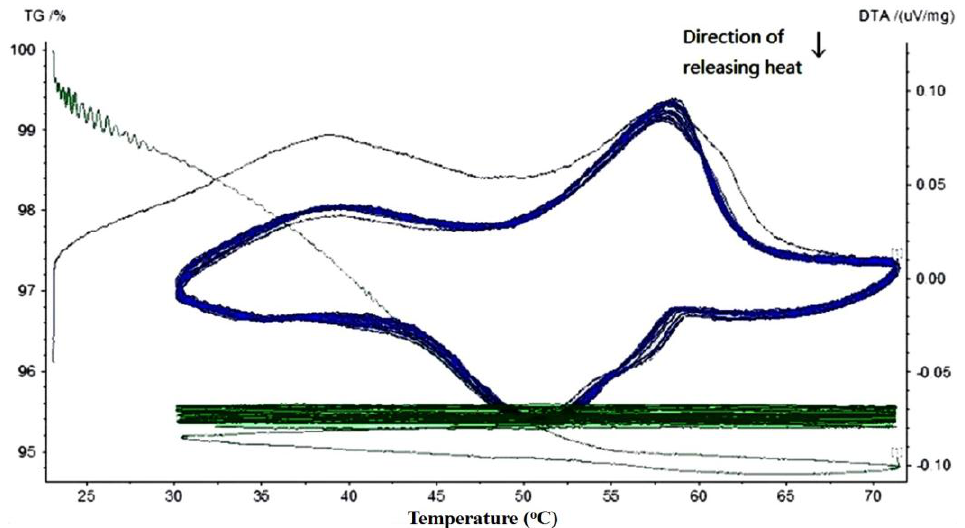
Figure 10. TG-DTA curve of the